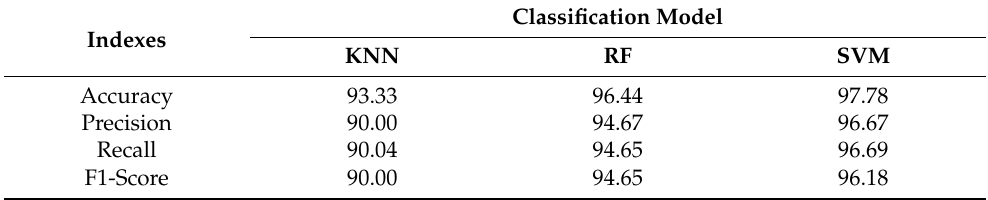
Table 3. Comparison of the overall average recognition ability of different classification models